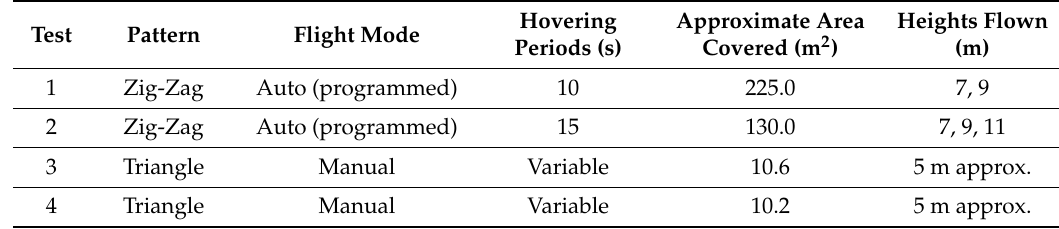
Table 4. Characteristics of the four flight tests